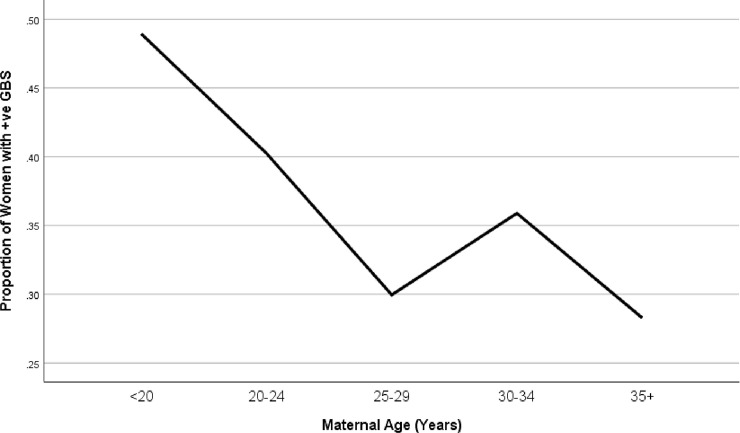
Prevalence of maternal GBS colonization by age group.The Figure demonstrates that overall the youngest mothers (<20 years) had the highest rates of GBS colonization (49%) while the oldest mothers (35+ years) had the lowest rates (28%) although there was a small spike in mothers 30 to 34 years (P of Trend = 0.023).